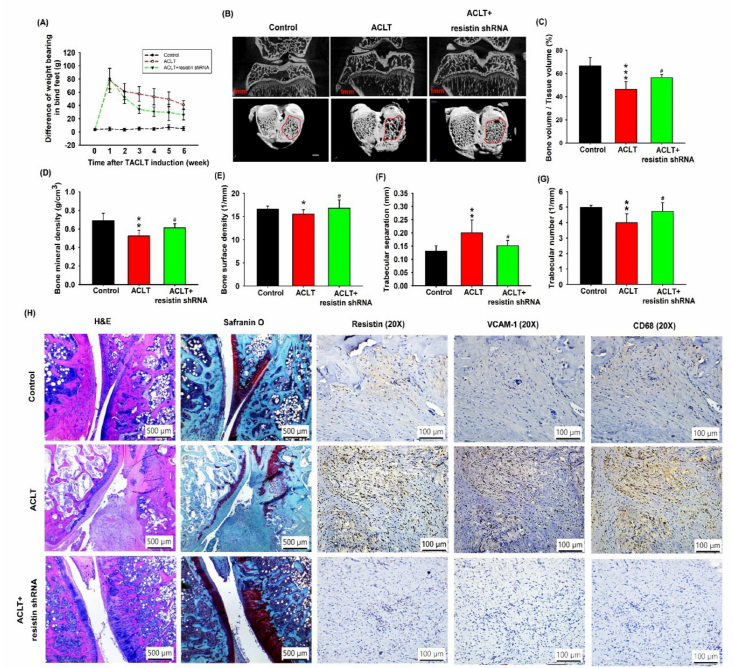
Figure 6. Resistin shRNA ameliorates the histologic severity of OA. ( A ) Between-group di ff erences